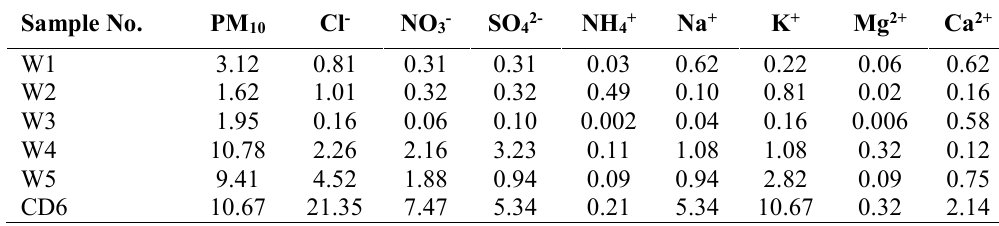
Table 3 Emission flux of PM 10 and ions, g kg -1 Sample No.